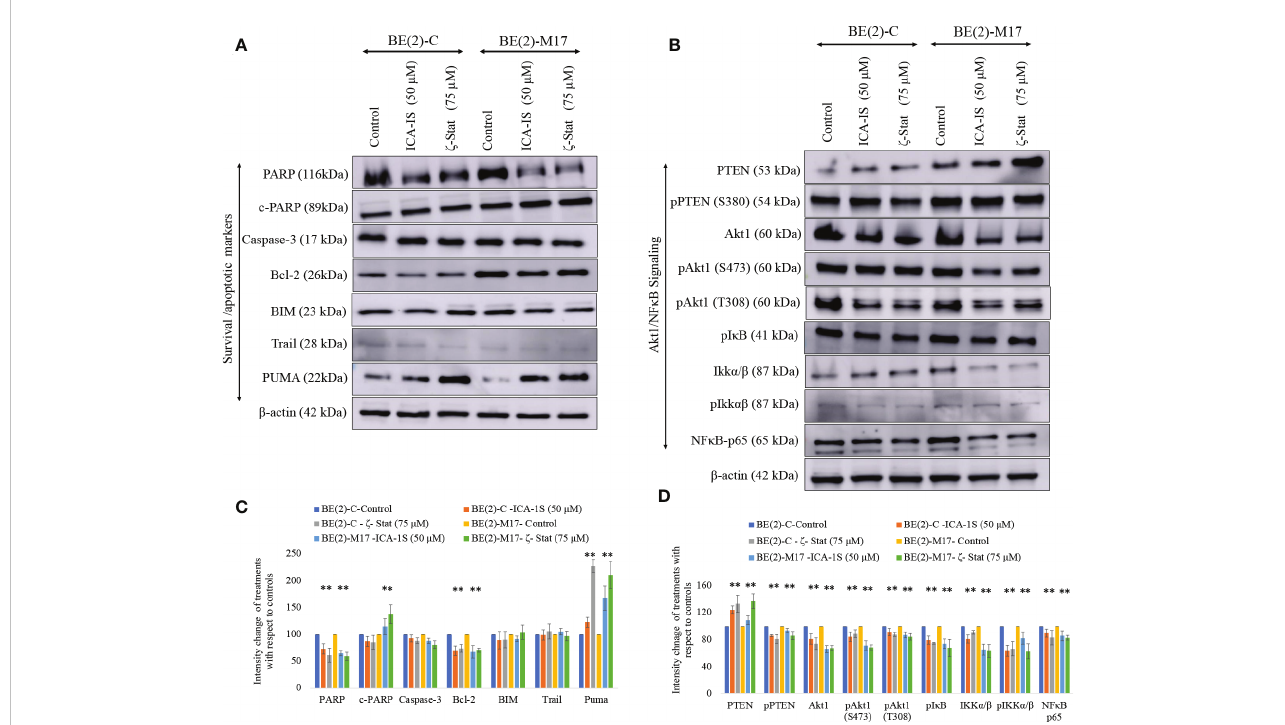
FIGURE 3 Effect of ICA-1S and z -Stat on apoptosis and Akt1/NF- k B signaling in NB cells. (A) Western blots of the expression of the protein levels of total PARP, cleaved PARP, Caspase-3, cleaved Caspase-3, Bcl-2, BIM, TRAIL and PUMA. (B) Western blots of the expression of PTEN, phosphorylated PTEN, Akt1, phosphorylated Akt1 (S473), phosphorylated Akt1 (T308), phosphorylated I k B, IKK a / b , phosphorylated IKK a / b and NF- k B p65 for the inhibitor treatments (50 µM of ICA-1S and 75 m M of z -Stat). Protein (60-80 µg) was loaded into each well and b -actin was used as the housekeeping marker in each Western blot. (C) Densitometry bar graph for Western blots in A). (D) Densitometry bar graph for Western blots in B). Experiments ( N = 3) were performed and representative bands are shown. Graphs depict percentage change of treated samples with respect to their controls and mean ± SD are plotted. Statistical signi fi cance is indicated by asterisk as * P <